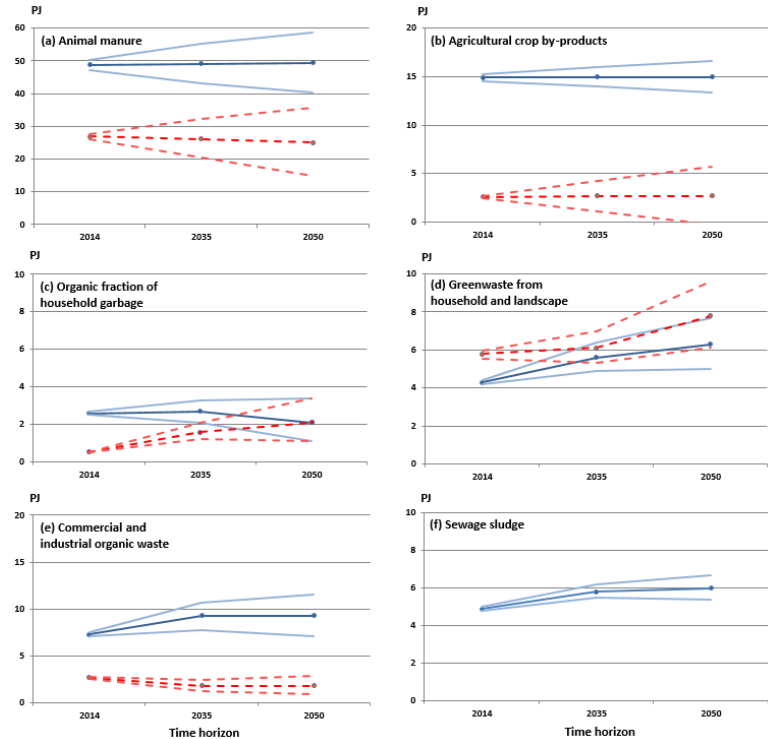
Figure 3. Mean of the expected development of biomass potentials in petajoules (PJ) in 2035 and 2050, with indication of the uncertainty (95% confidence interval) from the Monte Carlo simulation. Theoretic potentials are in blue full lines, and sustainable potentials are in red dotted lines.